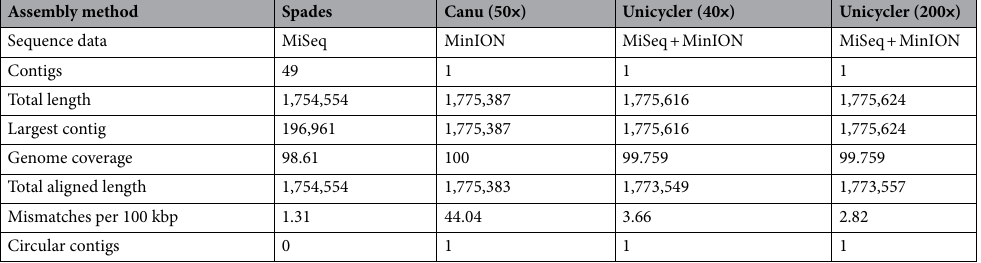
Table 3. C. jejuni RM1221 Assemblies. Genomes for C. jejuni reference strains RM1221 were assembled using SPAdes, Canu, or Unicycler and compared to the reference genome using QUAST. The MinION data was filtered to an estimated coverage of 40 × , 50 × , or 200 × using a genome size of 1.7 Mbp.